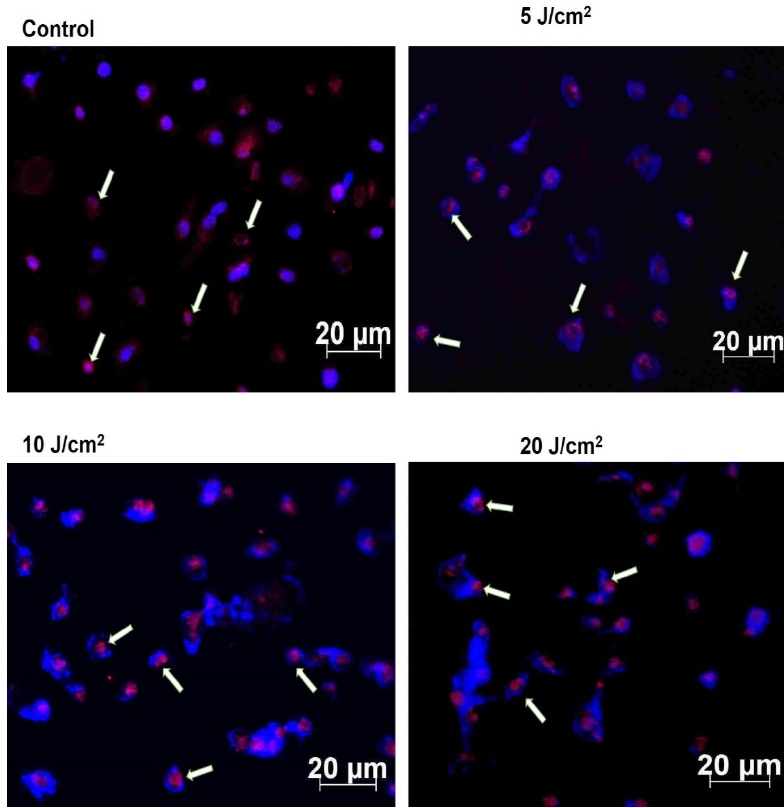
Figure 4. Evaluation of p53 expression in MCF-7/DOX cells. The p53 protein in pink is shown against the blue nuclear matrix in different fluencies of light at 5, 10, and 20 J/cm 2 and the untreated control.